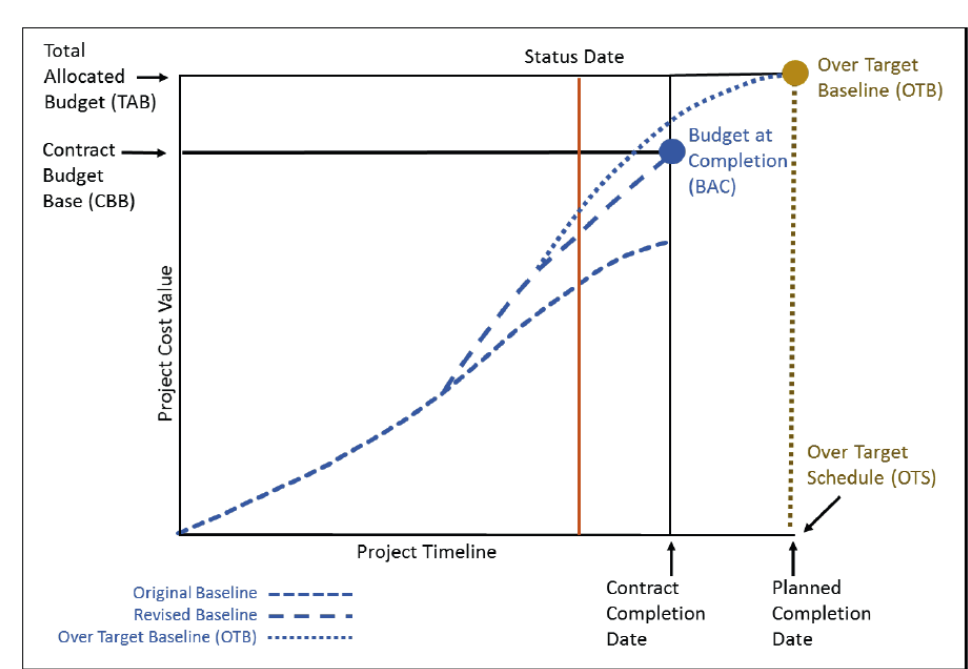
Fig. 15. Over Target Baseline & Over Target Schedule (NDIA IPMD,